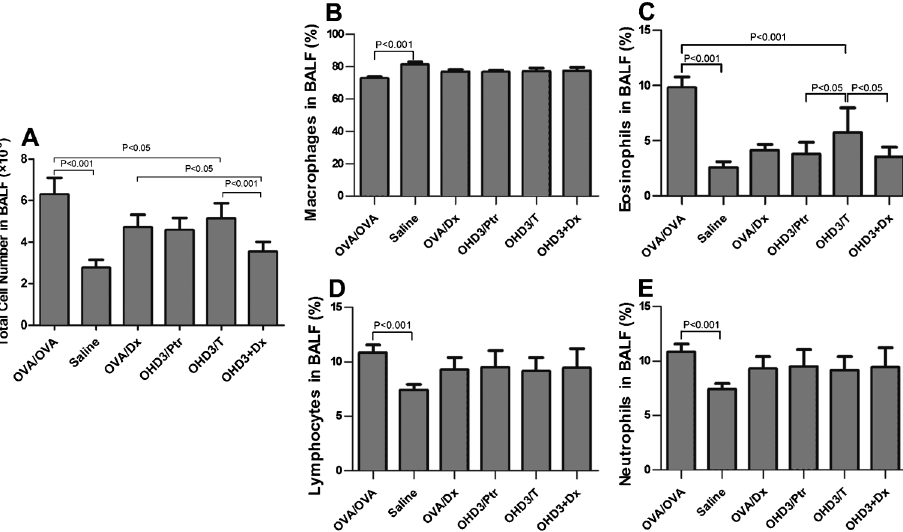
Figure 1. Effects of different treatments on the number of total and differential cells in bronchoalveolar lavage fluid (BALF). Data are reported as means±SD (n=5/group). A , The total cells in the BALF were significantly higher in the OVA/OVA group than in the control group (P , 0.001). In the OHD/3 Ptr group, as well as the OHD3/T, OVA/Dx or OHD3++Dx groups, the total BALF cells were decreased compared to those in the OVA/OVA group (P , 0.05). The total cell number was also lower in the OHD3++Dx group than in the OHD3/T or OVA/Dx groups (P , 0.05). B - E , There was a significantly higher percentage of eosinophils and lymphocytes in BALF, but a decrease in the percentage of macrophages in the OVA/OVA group compared with the saline control animals (P , 0.001). The proportion of eosinophils in the BALF from OHD3/Ptr, and OHD3/T and OHD3++Dx groups was less than that from the OVA/OVA group (P , 0.001, C ). The eosinophil percentage was significantly lower in the OHD3++Dx group than in the OHD3/T group (P , 0.05). There was a slight but significant decrease in the eosinophil percentage in the OHD3/Ptr group than in the OHD3/T group (P , 0.05, C ). ANOVA and Student-Newman-Keuls tests were used for statistical analyses. OHD3/Ptr: 1,25(OH) 2 D 3 pretreatment group; OHD3/T: 1,25(OH) 2 D 3 treated group; OVA/OVA: asthma group; OVA/Dx: dexamethasone treated group; saline: the control group; OHD3++Dx: dexamethasone and 1,25(OH) 2 D 3 treated plus Dx treatment group compared to the 1,25(OH) 2 D 3 - treated and the Dx-treated groups (P , 0.05, Figure 2G).